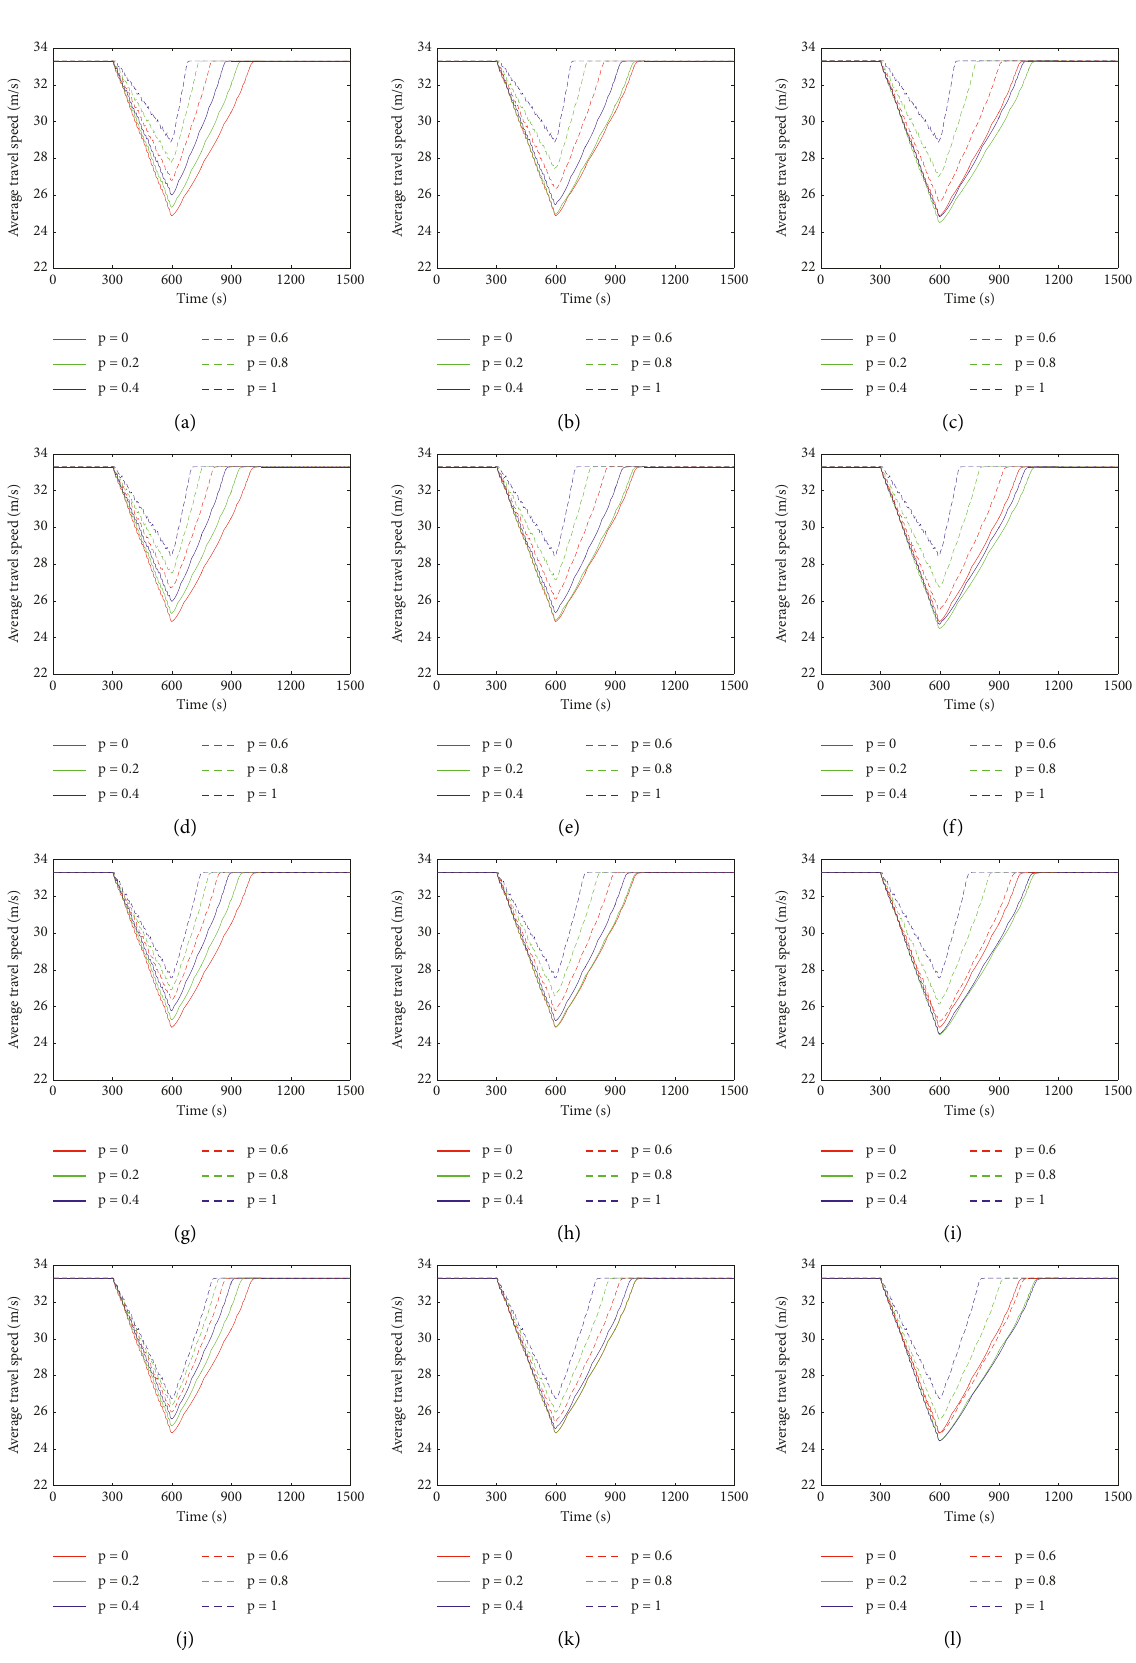
Figure 11: Average travel speed under different model parameters: (a) t